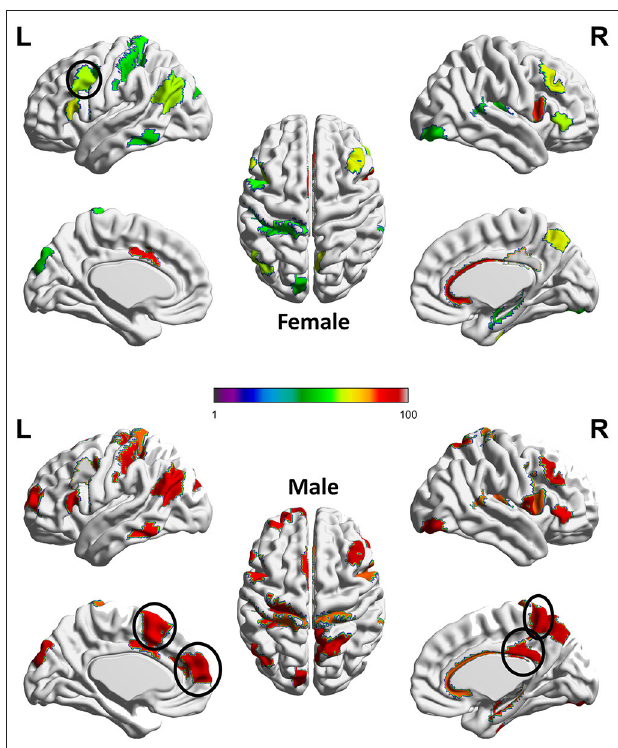
FIGURE 4 | Sex difference identified for ATTN. The color indicates the region involved in the ATTN process and the hotter color indicate the stronger involvement and the cooler color indicate the inverse. Permutation tests have been adopted to confirm the significance of this sex difference ( p < 0.01).The main sex differences are in several regions, which are highlighted using a black circle. These regions include Left Paracentral lobule, Right Posterior cingulate and Left dorso-medial prefrontal cortex, Right Precuneus, and Left